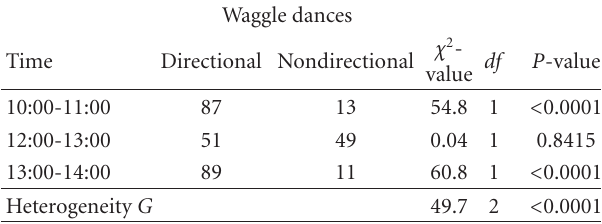
Table 1: Numbers of directional and nondirectional components in the waggle dances observed over three time periods—10:00 to